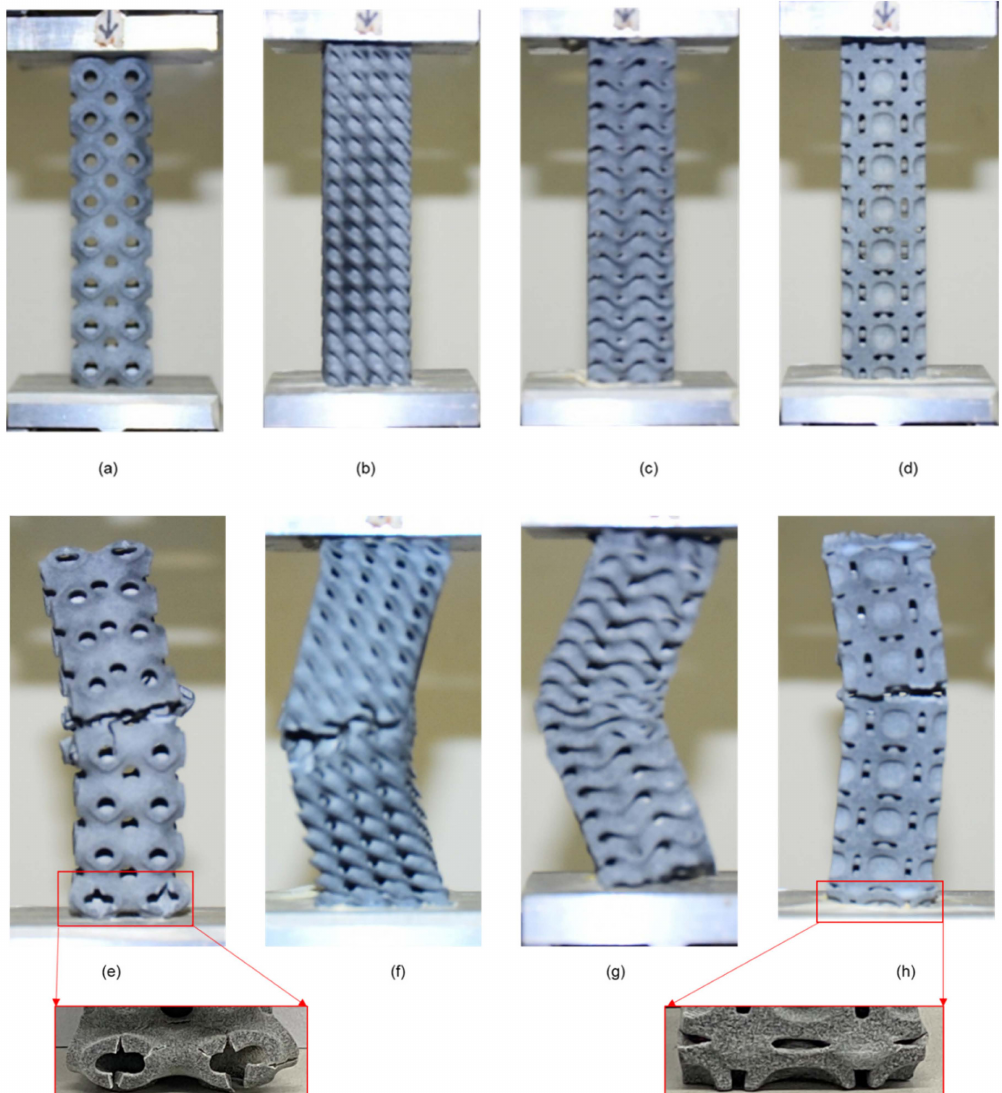
Figure 8. Samples of the 2 × 2 × 8 setup reduced to 0 percent compression: ( a ) Schwarz-P, ( b )